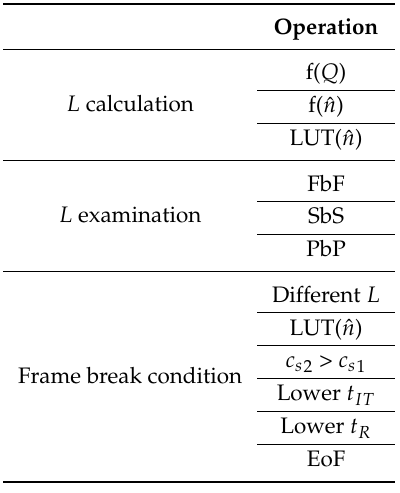
Table 1. Classification of Dynamic Frame Slotted Aloha (DFSA) frame update